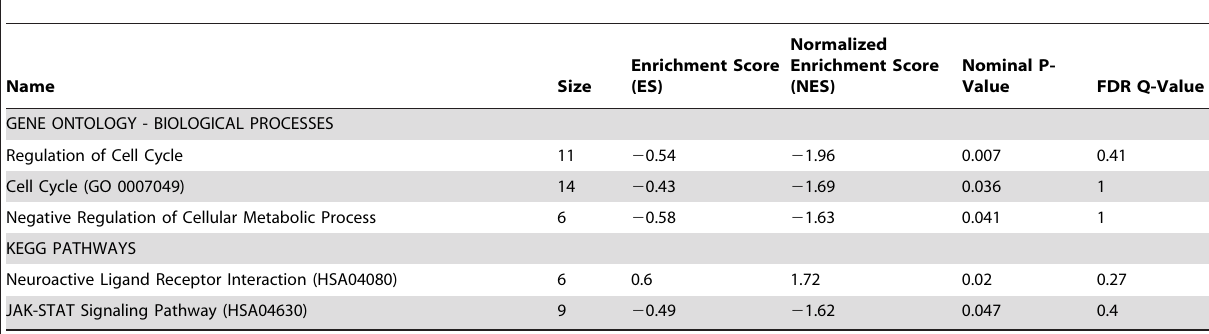
Table 4. Candidate enriched gene sets for differentially methylated genes associated with HPV